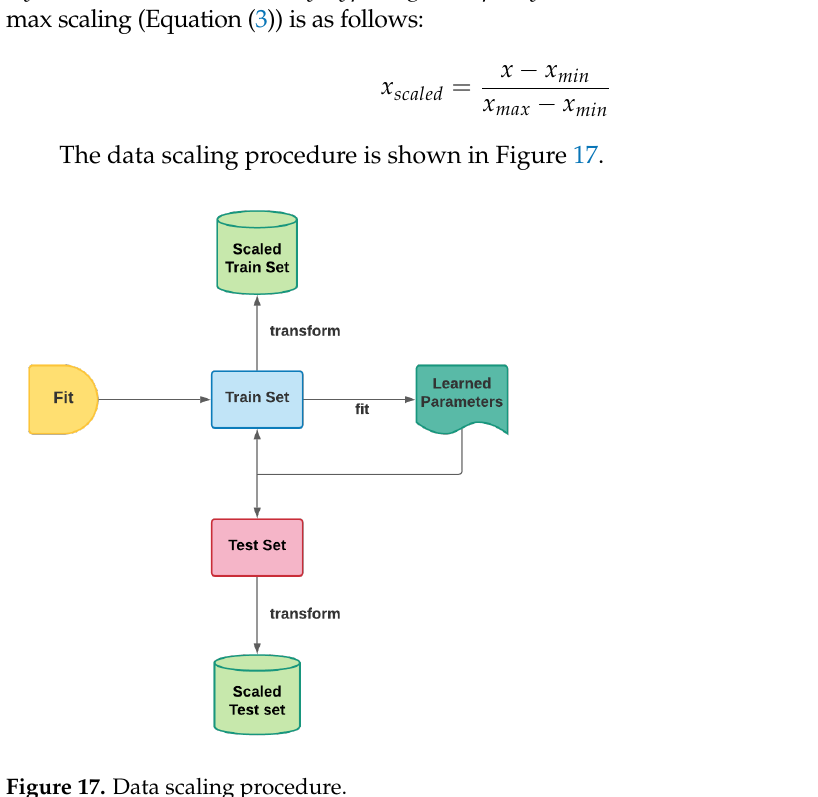
Figure 17. Data scaling